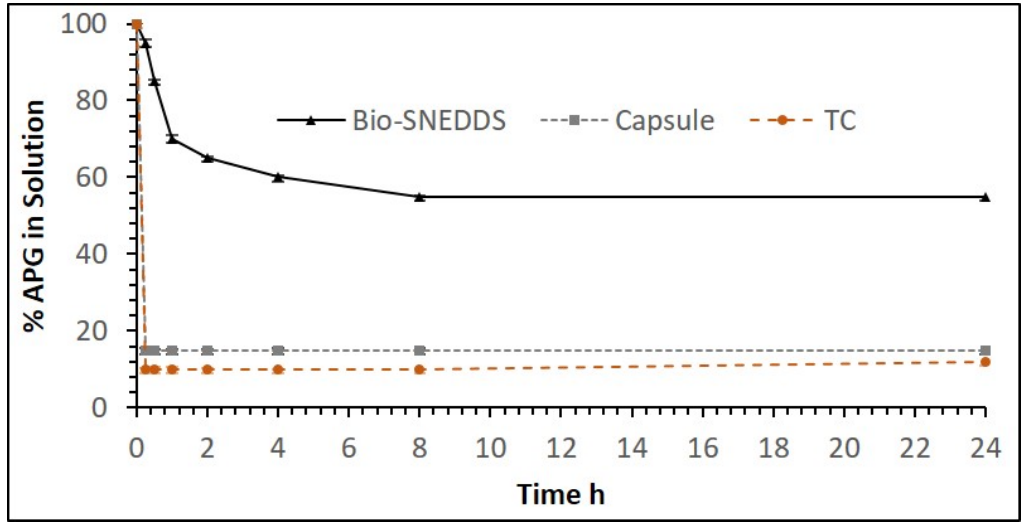
Figure 6. The percentage of APG in the solution over 24 h after 1:100 dilution in the aqueous media (water). Formulations studied: the Bio-SNEDDS of F11 (CoFA: CMCM: TC (3:1:1)/HCO30 [1/1]), the commercial APG capsule and F14 (TC only formulation). Data are presented as mean ± SD, ( n = 3).